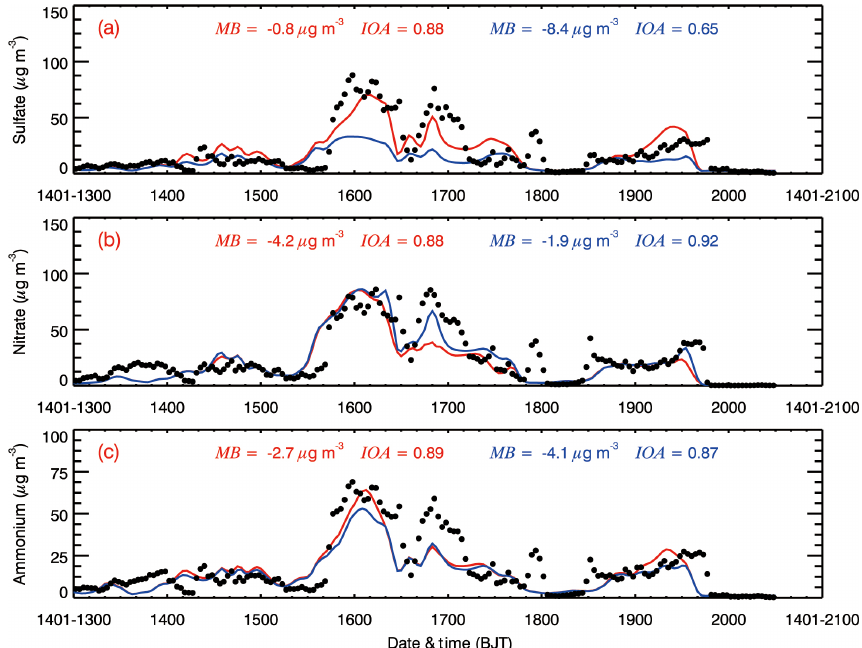
Figure 12. Same as Fig. 11, but in Beijing from 13 to 21 January